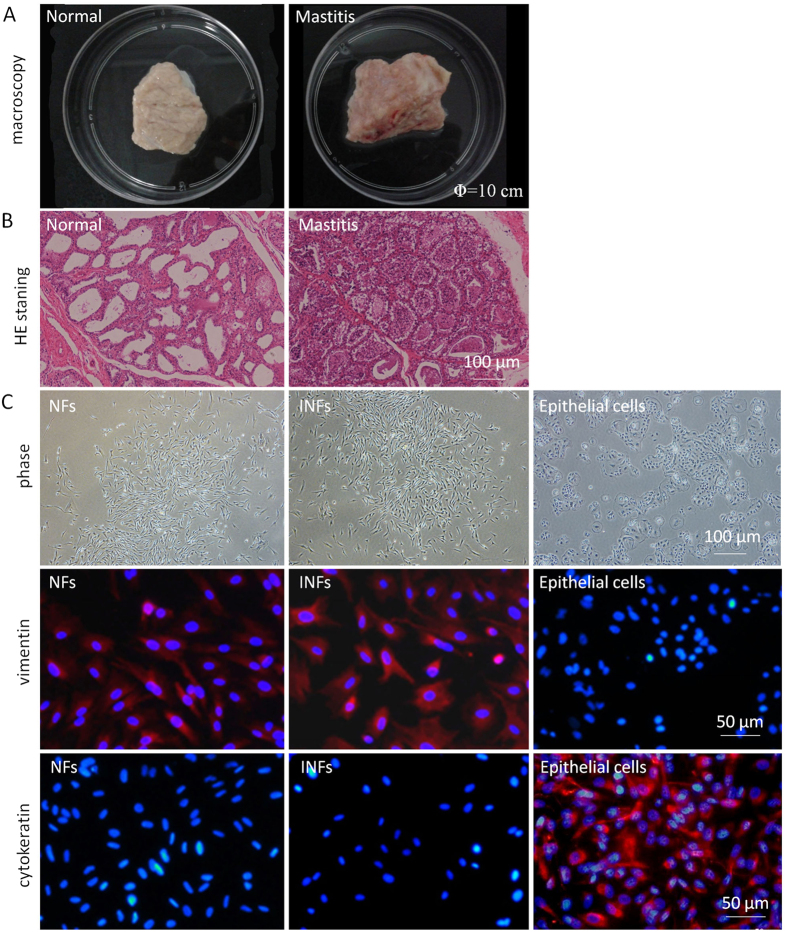
Collection of representative mammary tissue samples and extraction of fibroblasts and epithelial cells.(A) Normal and mastitic mammary tissues were distinguished by macroscopic examination, as described in the text. Φ: diameter of dishes. (B) The representative pathological appearance of normal and mastitic mammary tissues was confirmed by hematoxylin and eosin (H&E) staining. (C) Normal fibroblasts (NFs), inflammation-associated fibroblasts (INFs), and epithelia cells isolated from the tissues were examined by phase-contrast microscopy and immunostaining for vimentin or cytokeratin; nuclei were stained with DAPI. Both NFs and INFs exhibited an identical long and spindle-shaped morphology and vimentin expression and negative staining for cytokeratin. By contrast, epithelial cells showed cobblestone-like appearance, positive cytokeratin expression, and negative vimentin expression. All representative images were obtained from one of three independently repeated experiments.